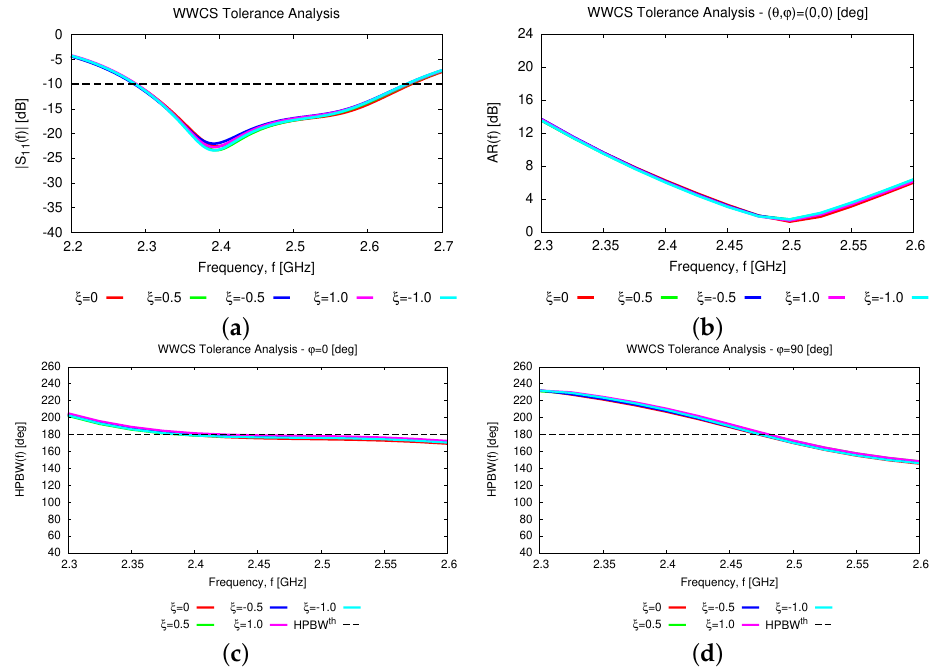
Figure 17. Numerical Assessment ( [ f min , f max ] = [ 2.3, 2.6 ] [GHz])—Behavior of the ( a ) reflection (cid:12) (cid:12) ( dB ) (cid:12) (cid:12) ( f , θ = 0, ϕ = 0 ) , and HPBW ( f ) along the ( c ) ϕ = 0 [deg] ( f ) coefficient, (cid:12) S (cid:12) , ( b ) axial ratio, AR 11 and ( d ) ϕ = 90 [deg] elevation planes of the WWCS radiating element for different settings of the manufacturing tolerance ξ on the feeding line ( W f ) and the parasitic ring ( W r ) widths.